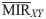
Application of the proposed method to correlated normal-variates data.Panel (a) shows the scatter matrix of nine data sets split into three groups (first group: x1, x2, x3, second group: x4, x5, x6 and third group: x7, x8, x9). Each group consists of three correlated normal-variates with zero correlation among the groups. Fig 5(a) shows the scatter matrix of the three groups of data (x1, …, x9). The circular pattern indicates that the two nodes are independent (or weakly correlated), whereas an elongated one shows strong correlation, either positive or negative depending on the orientation of the pattern. Panel (b) is the ordered MIR¯XY for the correlated variates. The red dash line corresponds to τ ≈ 0.06. Panel (c) shows the successfully inferred network resulting from (b).